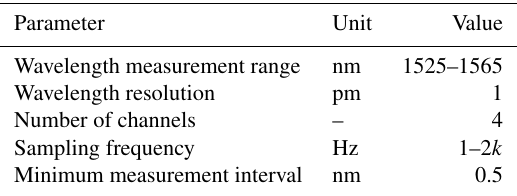
Table 3. Main parameters of the FBG wavelength demodulator. Parameter